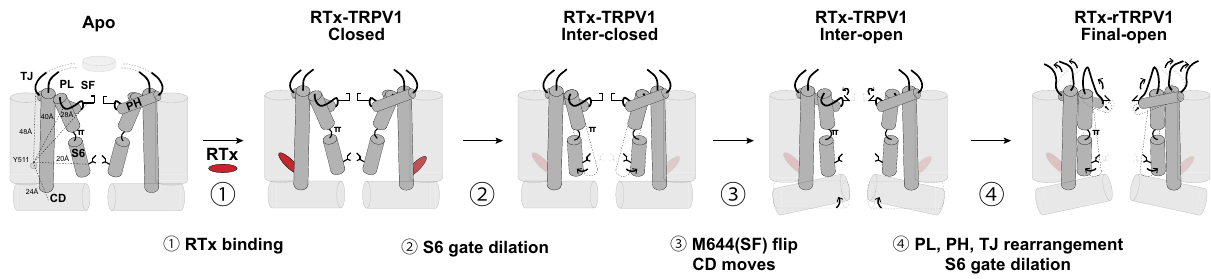
Fig. 7 RTx-mediated TRPV1 gating mechanism. In the unstimulated apo state, the channel is closed both at the selectivity fi lter and S6 gate. 1 Initially, RTx binds with no signi fi cant conformational changes. 2 RTx binding induces S6 gate dilation. 3 The M644 sidechain fl ips outward, and the CD moves towards the channel core. 4 Finally, rearrangement of the PL, PH, TJ results in further dilation of the S6